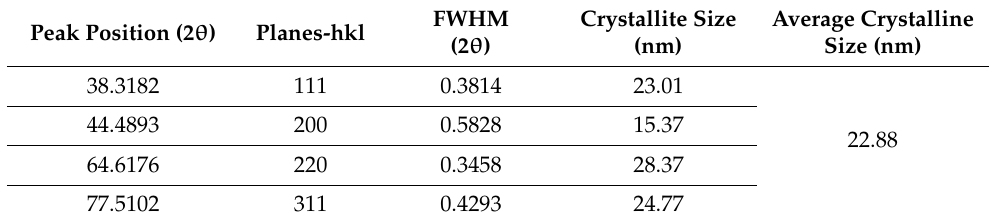
Figure 4. XRD pattern of AgNP displaying peak indices and 2 θ positions. (* shows the extra unassigned peaks of enzyme and its peptide). Table 3. Crystallite (Grain) size of AgNPs calculated using Debye–Scherrer’s equation using XRD data. Peak Position (2 θ )